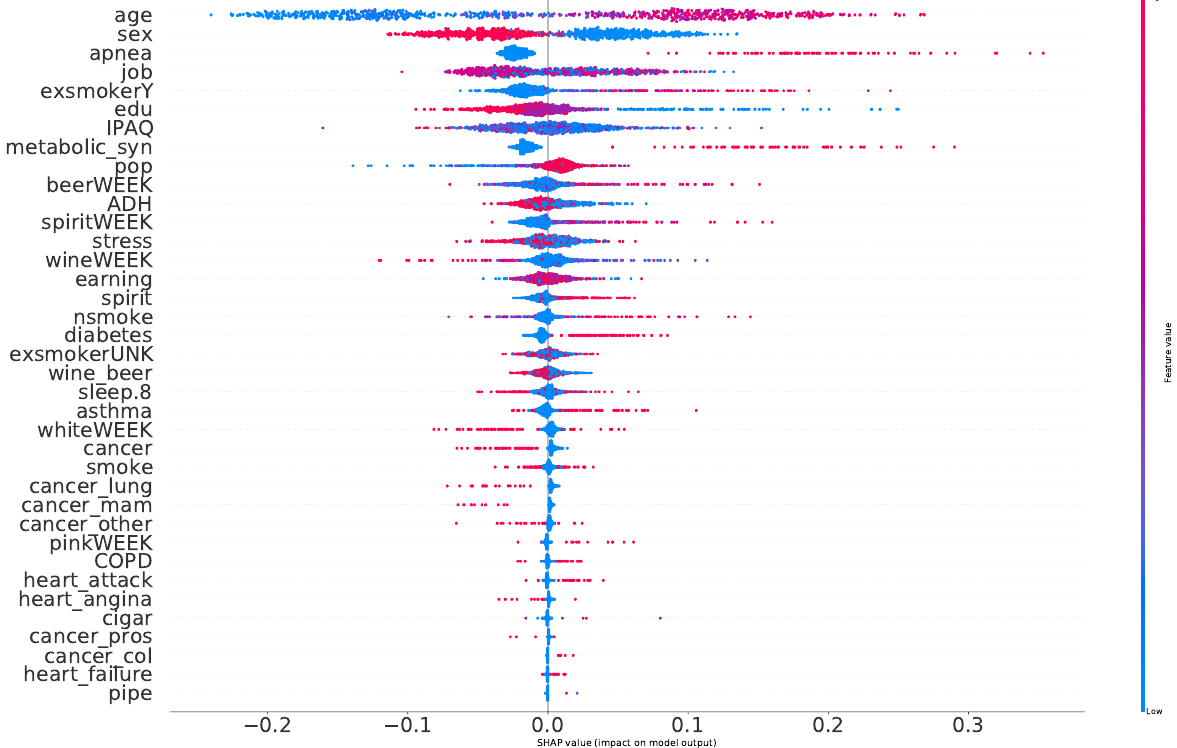
Figure 2. Impact of variables with SHAP, Random Forest with pathologies, and no